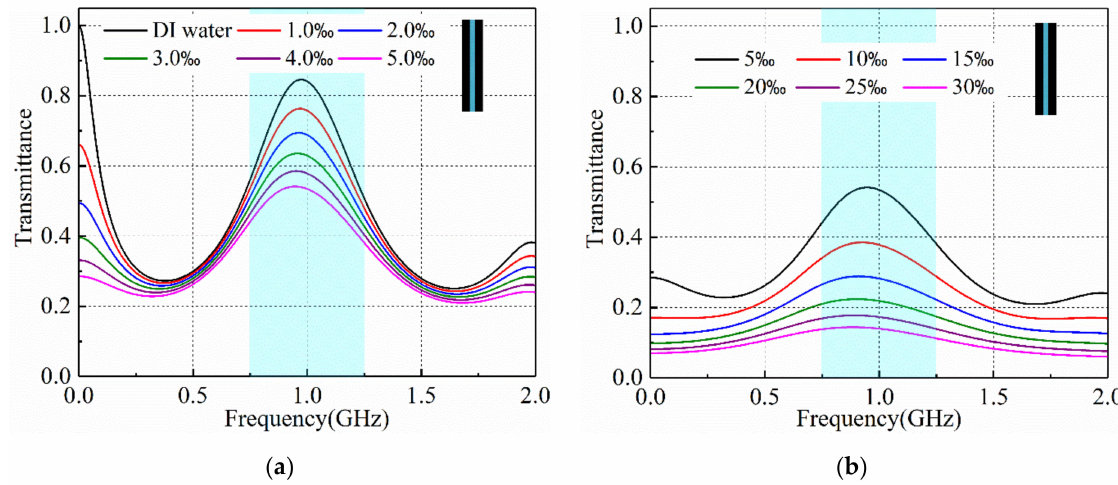
Figure 5. The transmittance spectra of the 3-layer defective MPC sensor with a salinity range of ( a ) 0–5‰, ( b )